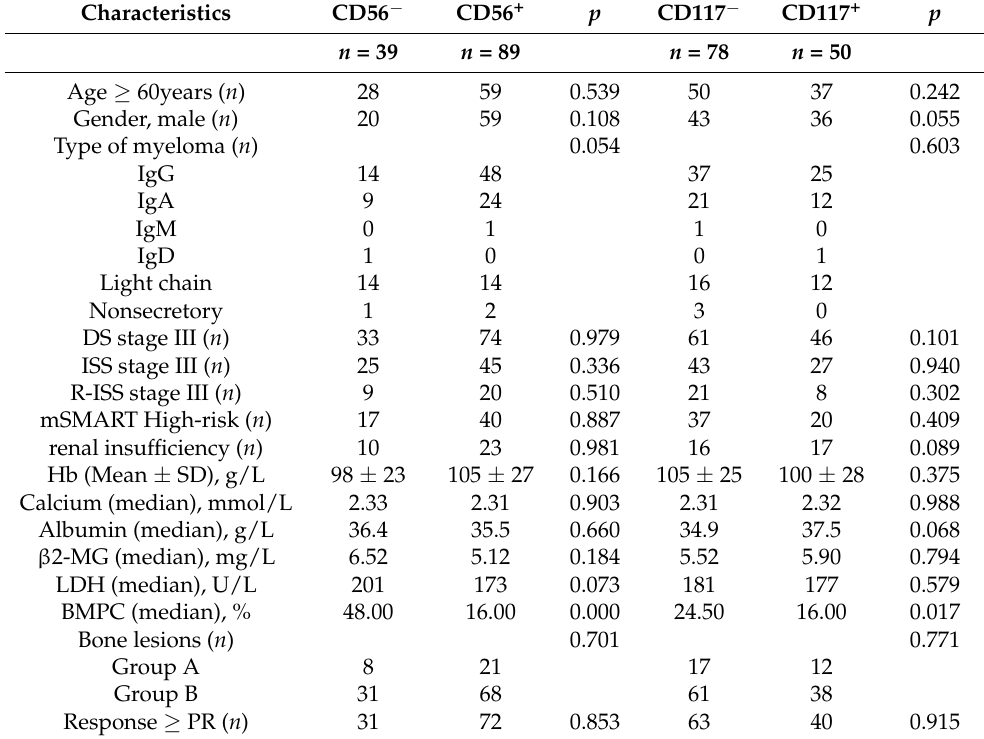
Table 1. MM patients with baseline characteristics linked to CD56 and CD117 expression.